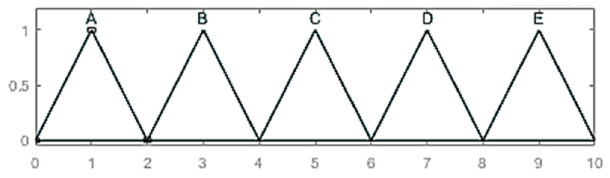
Figure 13. Input membership functions for C 2 H 6 . Figure 14. Faults’ severity output membership functions.